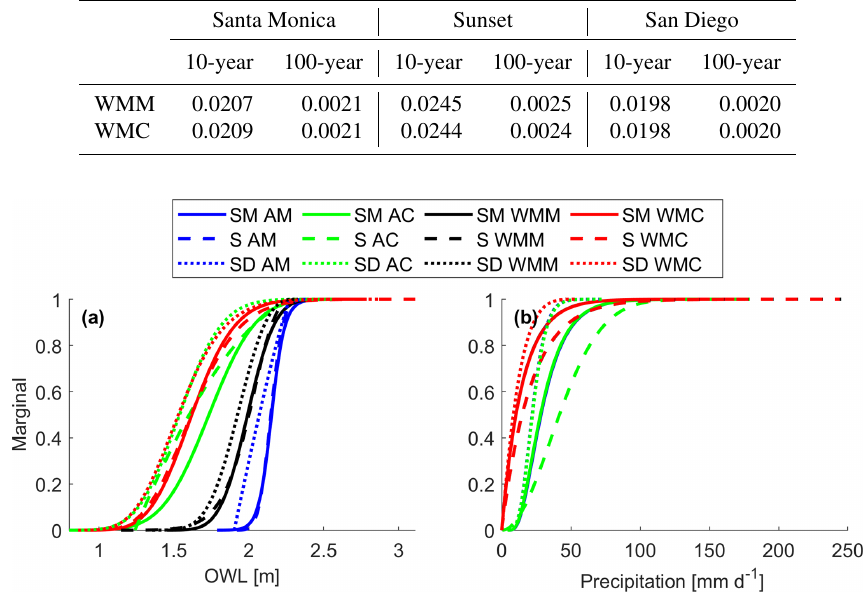
Table 3. Santa Monica, Sunset, and San Diego exceedance probabilities at the 10- and 100-year return periods for wet-season monthly maximum (WMM) and wet-season monthly coinciding (WMC) samplings.